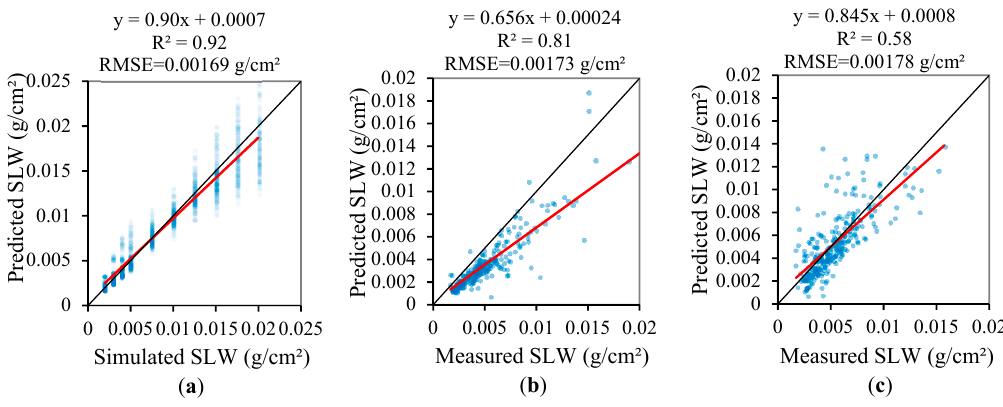
y = 0.90x + 0.0007 R² = 0.92